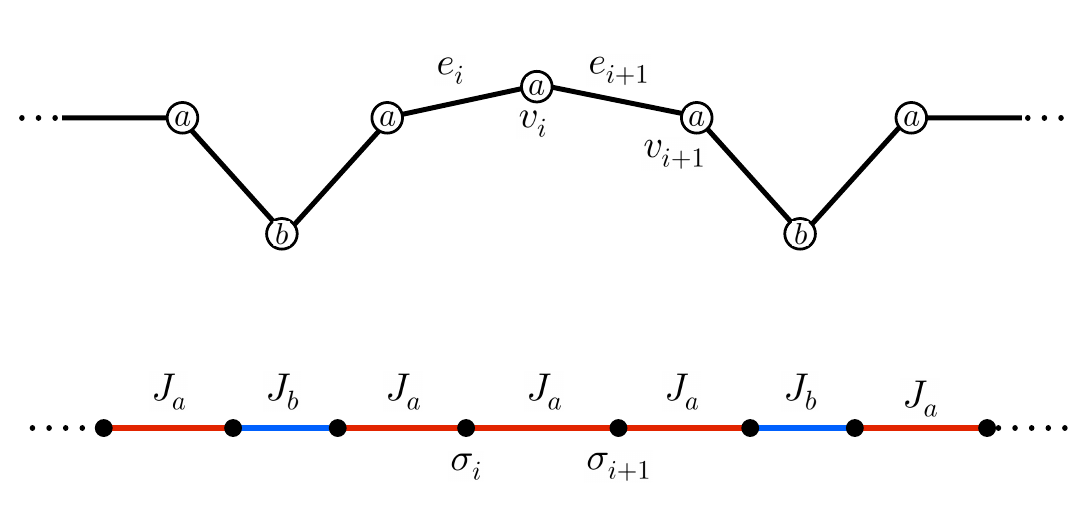
Figure 4: Construction of an aperiodic spin chain (bottom) based on the sequence of letters that the inflation procedure for a { p , q } tiling of the Poincaré disk (cf. Sec. 2.2) induces on the boundary (top). The letter sequence on the tiling’s boundary is asso- ciated to the coupling distribution in the corresponding spin chain. Different colors depict bonds with different couplings J with k = a , b k